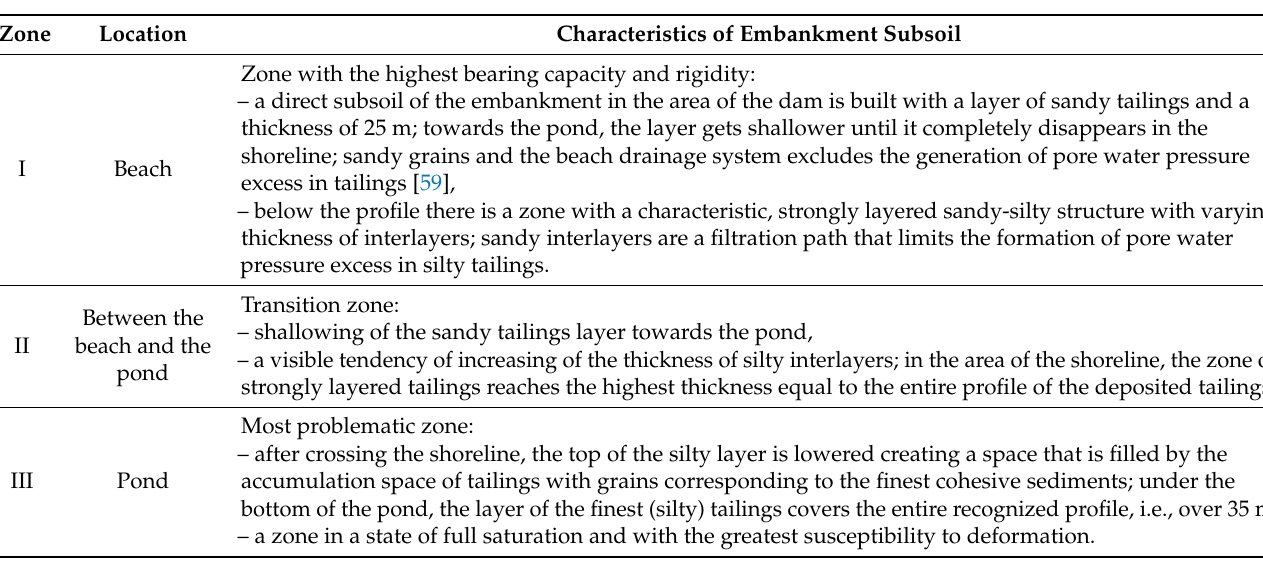
Table 1. Three-zone characteristics of the subsoil of the experimental embankment.